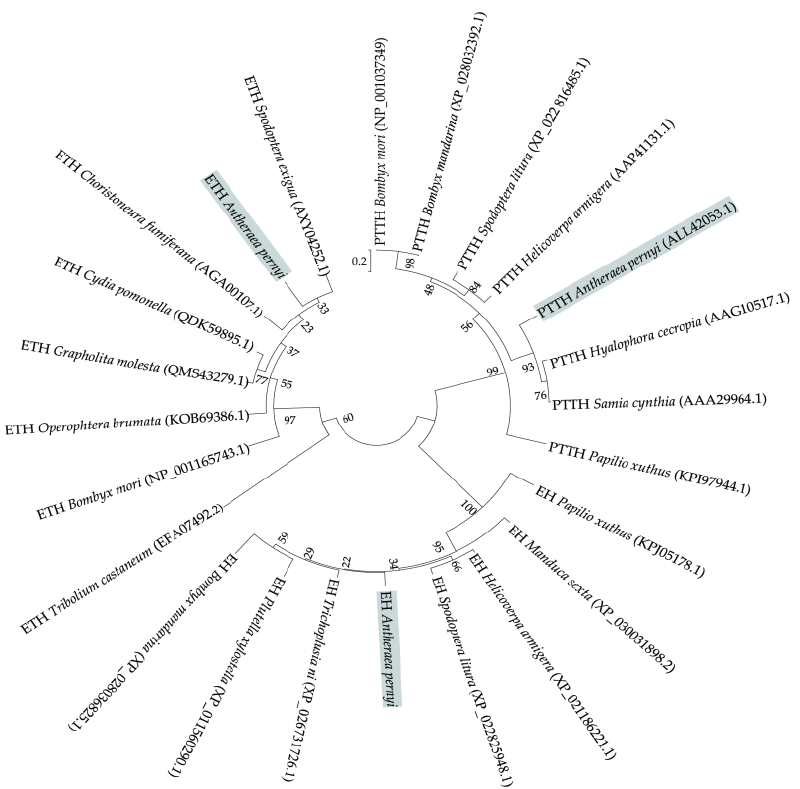
Figure 5. Phylogenetic tree constructed using PTTH, ETH, and EH sequences using MEGA7.0. Bootstrap percentage values are shown on the branches. GenBank accession numbers, along with organism names, are shown for all the sequences. Papilio xuthus (KPI97944.1), Tribolium castaneum (EFA07492.2), and Papilio xuthus (KPJ05178.1) were used for comparison as out-groups.